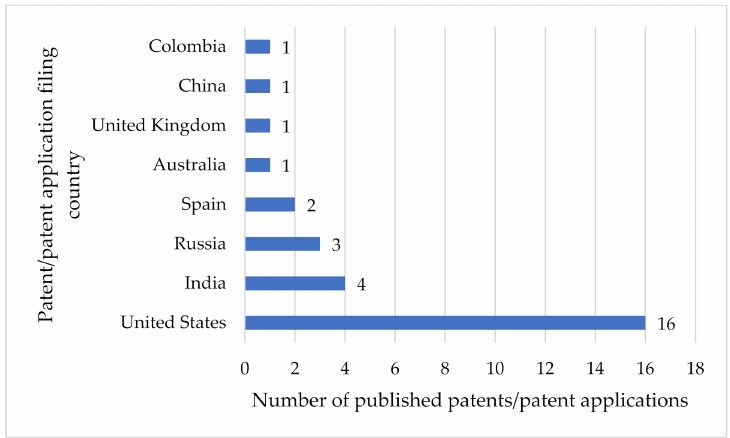
Figure 3. Patent-filing